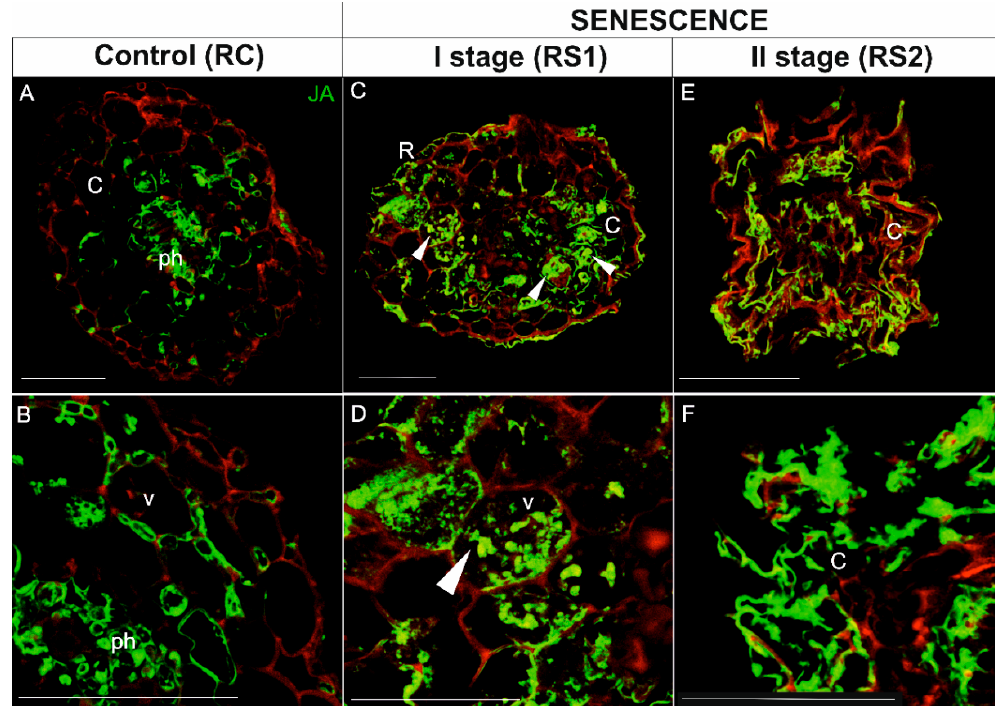
Figure 9. Immunolocalization of JA (green fluorescence) in fine, absorptive roots during senescence. ( A , B ), Root control (RC); ( C , D ) The first stage of root senescence (RS1); ( E , F ) The second stage of root senescence (RS2). Autofluorescence (red) of the cell wall was recorded to visualize the cell and/or organ shape. Abbreviations: R, rhizodermis; C, parenchyma cortex cells; Ph, phloem; X, xylem. Scale bars = 50 µm.